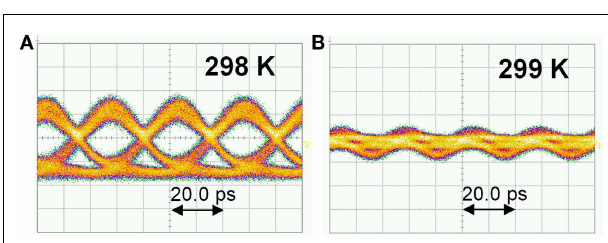
FIGURE 8 | Eye diagrams of Si-waveguide DL MZI at (A) 298 and (B) 299K